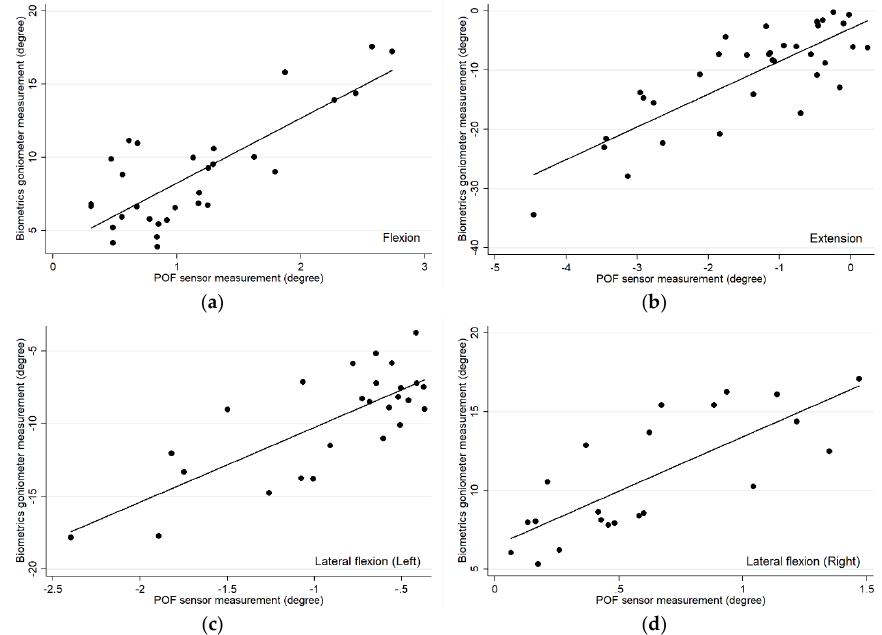
Figure 4. Scatter plots showing the linear relationship between the POF sensor and Biometrics goniometer for each movement including ( a ) flexion, ( b ) extension, ( c ) left lateral bend and ( d ) right lateral